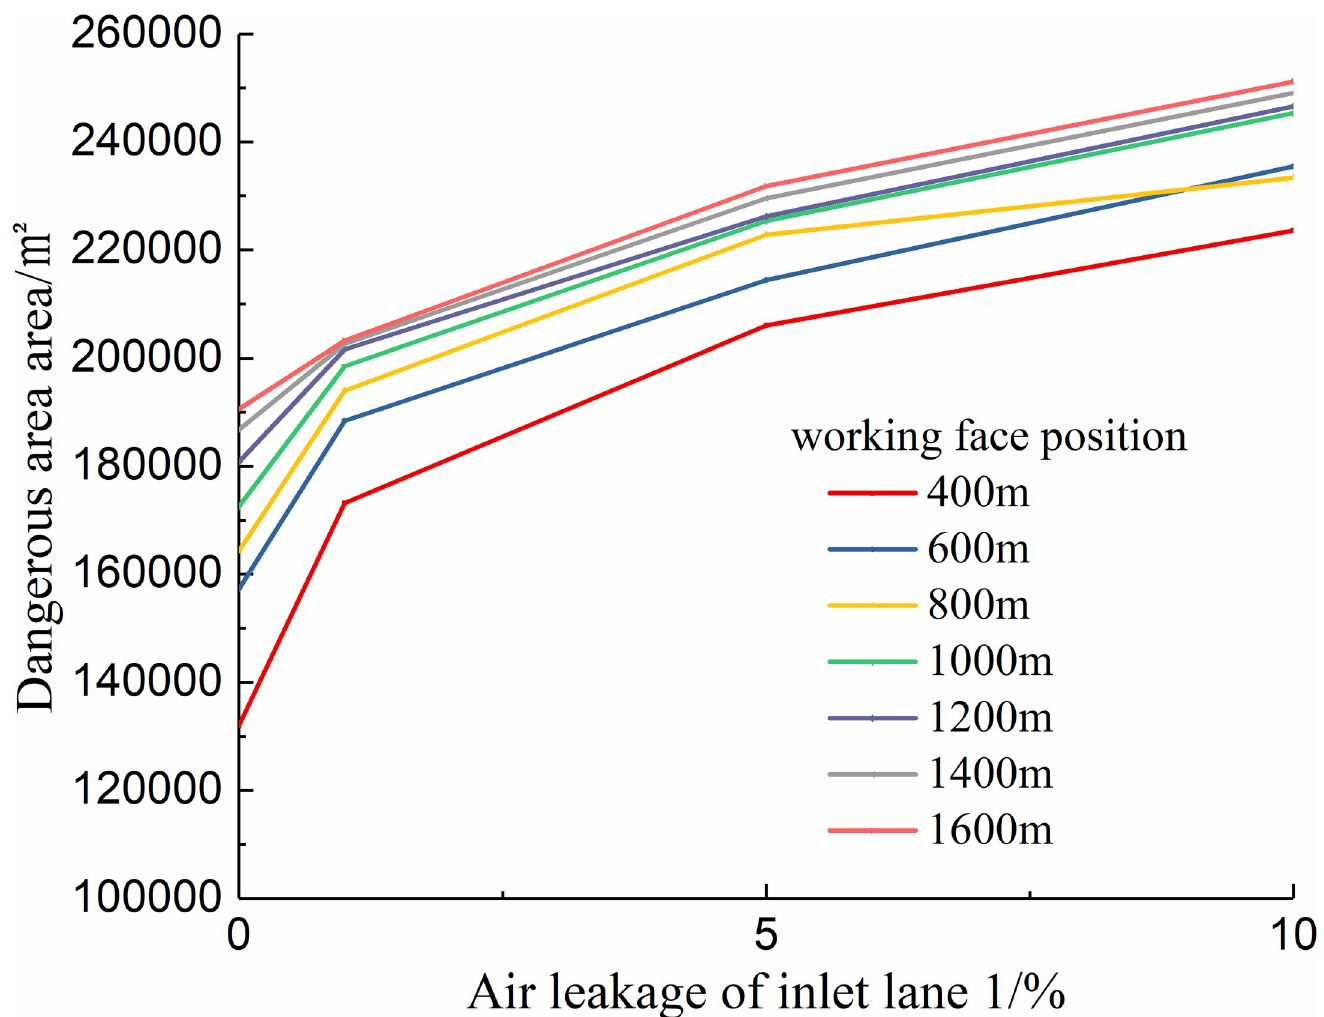
Fig 12. Change curve of the spontaneous combustion danger area under different air leakage.